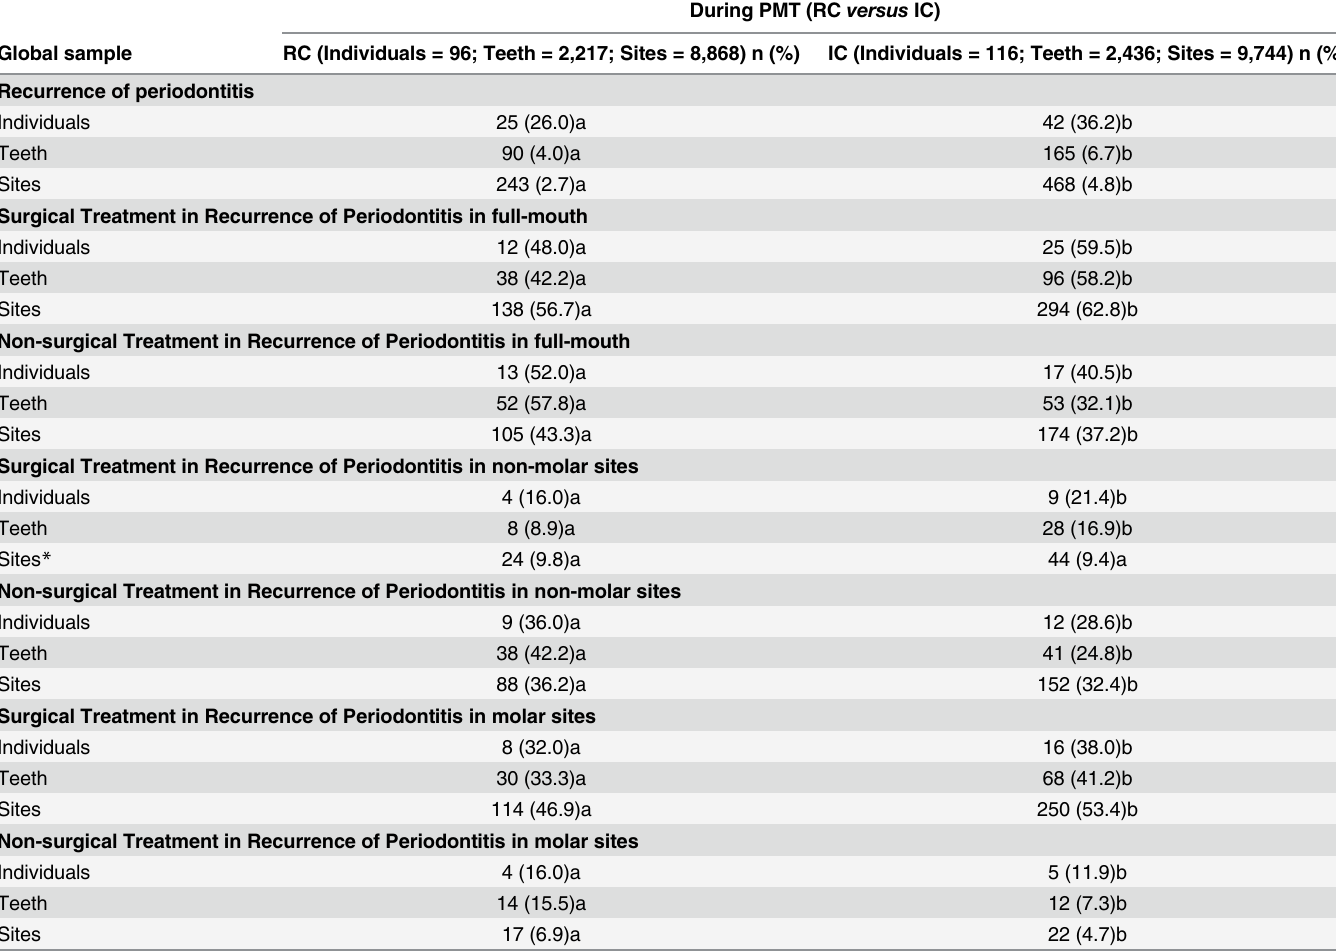
During PMT (RC versus IC)